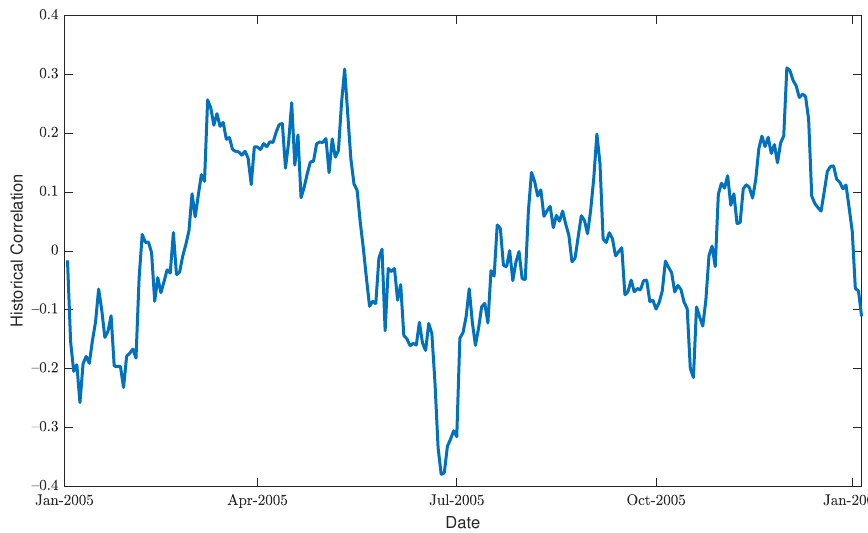
Figure 1. The 30-day historical correlations between S&P 500 and Euro/US-Dollar exchange rate, source of data: